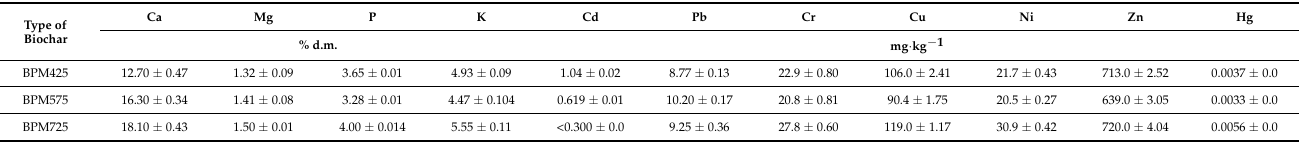
Table 3. Chemical composition of poultry-manure-derived biochars (selected elements).